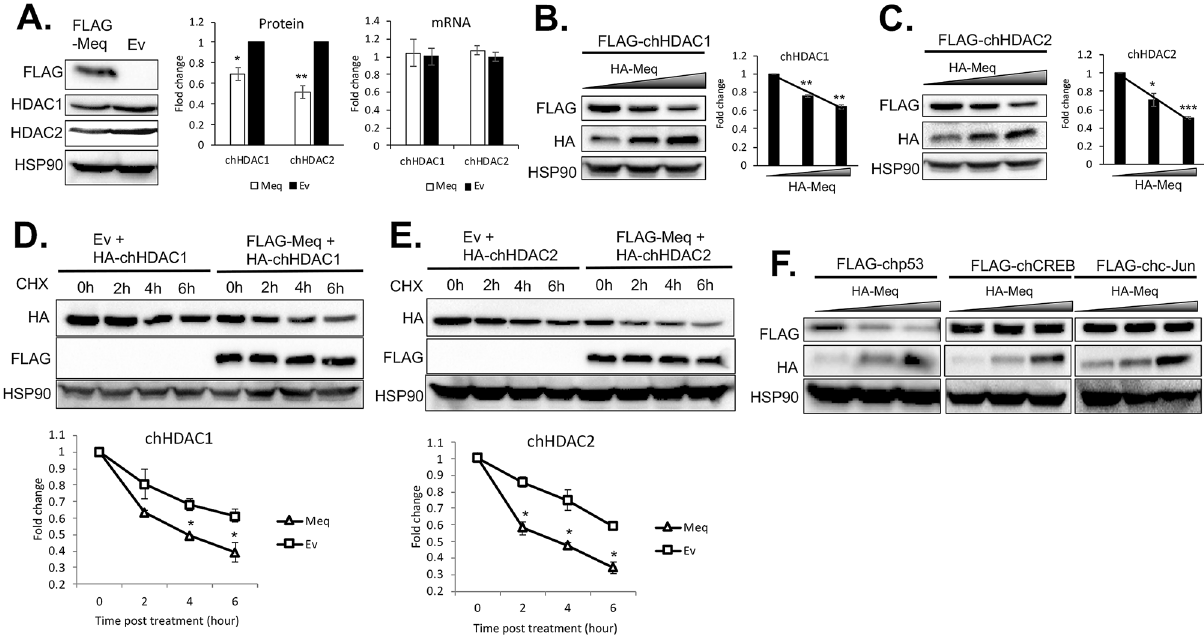
Figure 5. Meq mediates the degradation of chHDAC1 and 2. ( A ) DF-1 cells were transfected with pcDNA- FLAG-Meq or pcDNA empty vector (Ev) and 48 h later, cells were harvested for protein and RNA extraction. Western blot (WB) analysis was processed with the indicated antibodies (left) and quantified with Image J and presented as fold change compared to Ev (middle). qRT-PCR was processed with primers targeting chHDAC1 and chHDAC2 and presented as fold change compared to Ev (right). pcDNA-FLAG-chHDAC1 ( B ) or pcDNA- FLAG-chHDAC2 ( C ) were co-transfected with different amounts of pcDNA-HA-Meq into 293T cells for 48 h. Whole cell lysates were subjected to WB with the indicated antibodies (left). WB results were quantified with Image J, normalized to HSP90, and presented as fold change compared to the least amount of Meq transfection (right). pcDNA-FLAG-Meq or pcDNA Ev were co-transfected with pcDNA-HA-chHDAC1 ( D ) or pcDNA- HA-chHDAC2 (E) into 293T cells and 24 h later, cells were treated with cycloheximide (CHX, 1 mg/ml) for the indicated length of time. WB were performed with HA, FLAG, and HSP90 antibodies (upper). HA-chHDAC1 or HA-chHDAC2 protein levels were quantified with Image J, normalized to HSP90, and presented as fold change compared to non-treated cells (bottom). All experiments were repeated two times. Error bars indicate standard deviation (SD). ( F ) pcDNA-FLAG-chp53, pcDNA-FLAG-chCREB, or pcDNA-FLAG-chc-Jun were co-transfected with different amounts of pcDNA-HA-Meq into 293T cells and 48 h later, whole cell lysates were subjected to WB with the indicated antibodies. The statistical differences were analyzed by Student t test. * p < 0.05, ** p < 0.01, *** p <